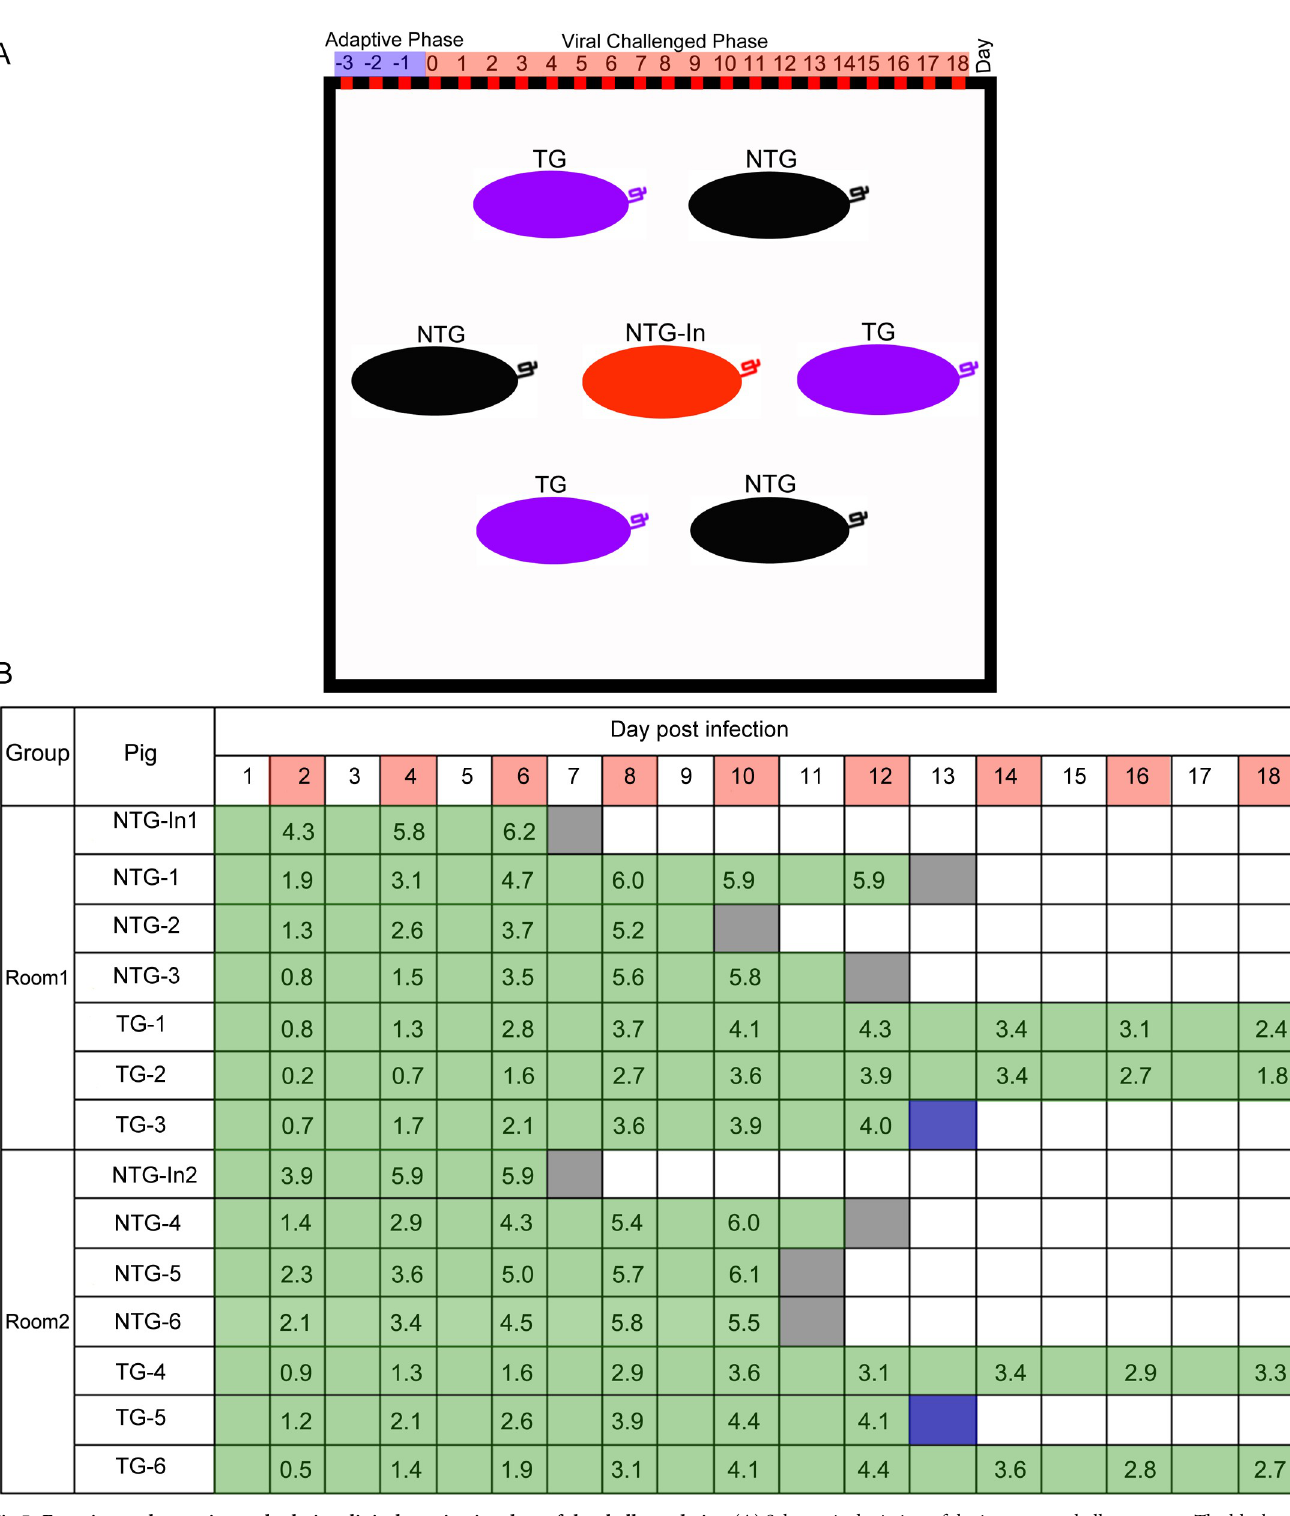
Fig 5. Experimental grouping and relative clinical monitoring data of the challenged pigs. ( A ) Schematic depiction of the in-contact challenge assay. The black box indicates a separate room. Different colours indicate different types of pigs. Each room included one non-TG pig that was injected with CSFV (NTG-In), three NTG pigs and three TG pigs. ( B ) Mortality and viremia in challenged pigs. The survival time of each pig is indicated by the length of the green bar. Red squares indicate the collection of blood samples. The terminal block colour indicates day and cause of death (black, found dead; blue, pigs (TG-4 and TG-5) euthanized for comparison to the dead NTG pig). The numbers for each day are the lg values of viral RNA copies present in the blood samples.